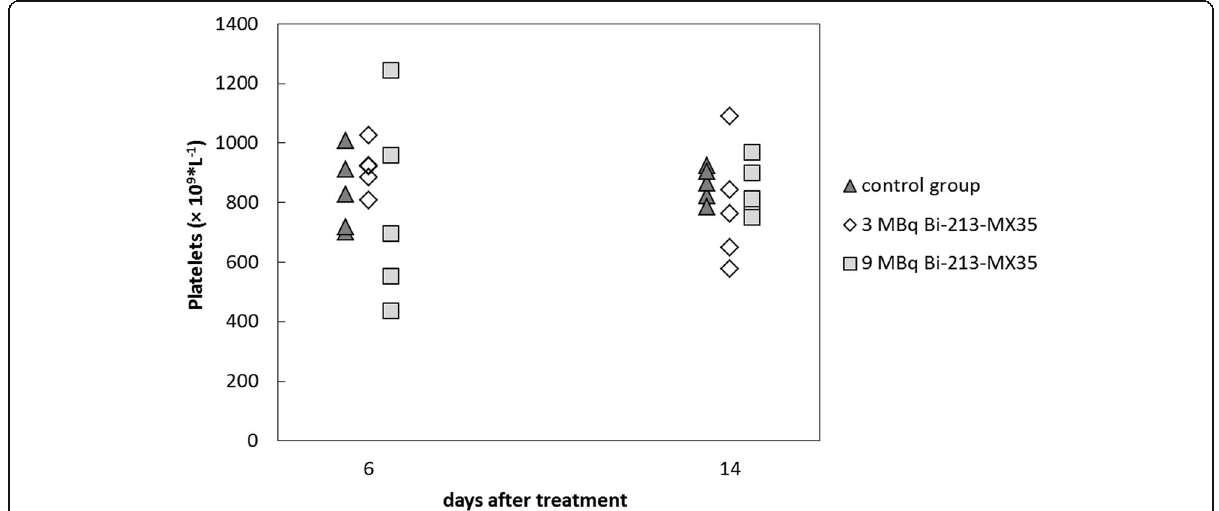
Fig. 3 Platelet counts measured in the blood samples taken from the tail vein 6 and 14 days after treatment. Each group consisted of five animals